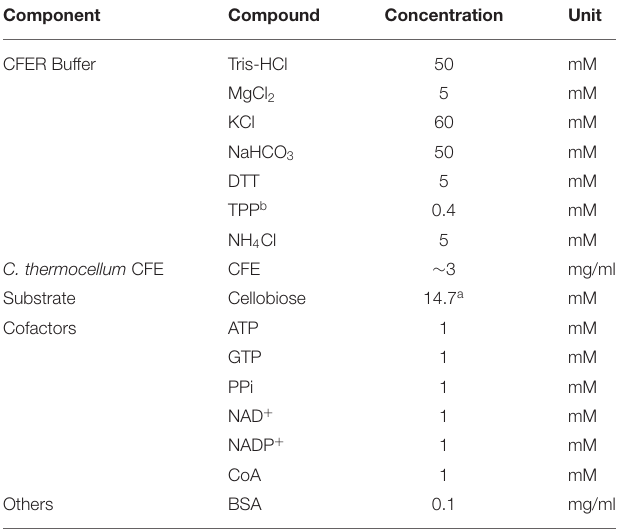
TABLE 1 | CFER assay